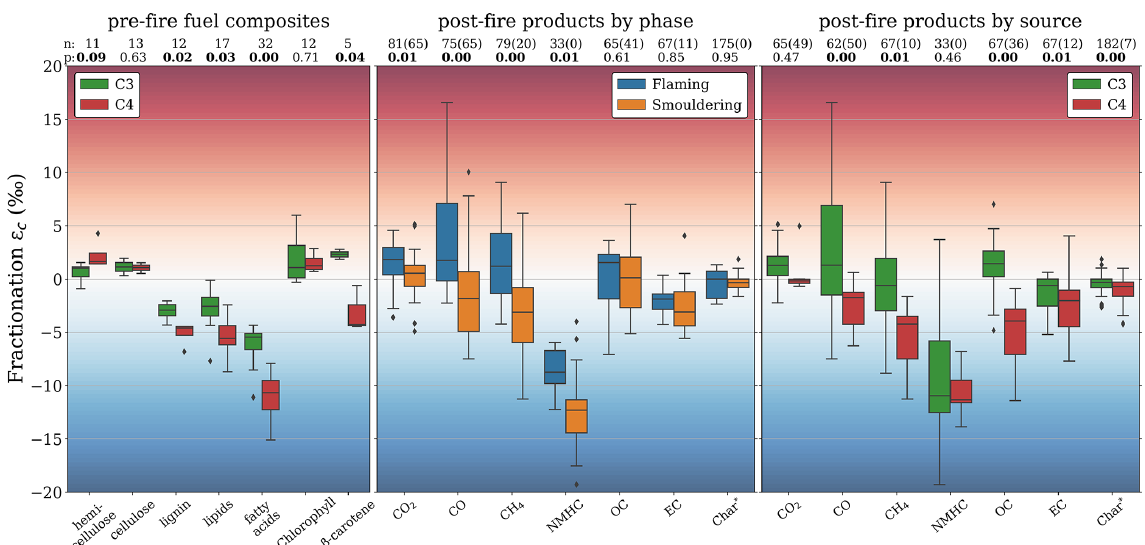
Figure 7. Left: δ 13 C fractionation of various sub-compounds of the fuel compared to the bulk plant (i.e. the combined sub-compounds) for C 3 (green) and C 4 (red) vegetation. Middle: δ 13 C fractionation in pyrolysis products for flaming (blue) and smouldering (orange) combustion phases. Right: δ 13 C fractionation in pyrolysis products for C 3 (green) and C 4 (red) vegetation. The first row of numbers over the boxplots (n) represent the number of individual δ 13 C measurements taken from literature and from this study combined, with the number from this study in parentheses. The second row (p) represents the P value calculated using a two-tailed t test with unequal